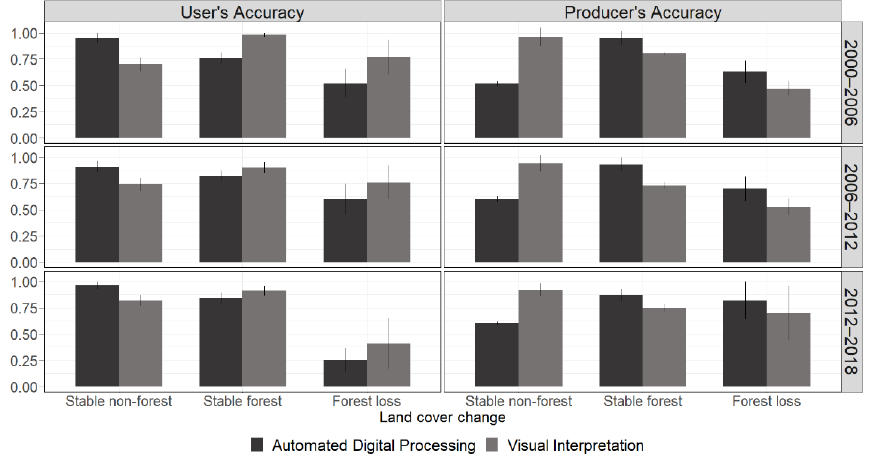
Figure 4. User’s accuracy and producer’s accuracy .